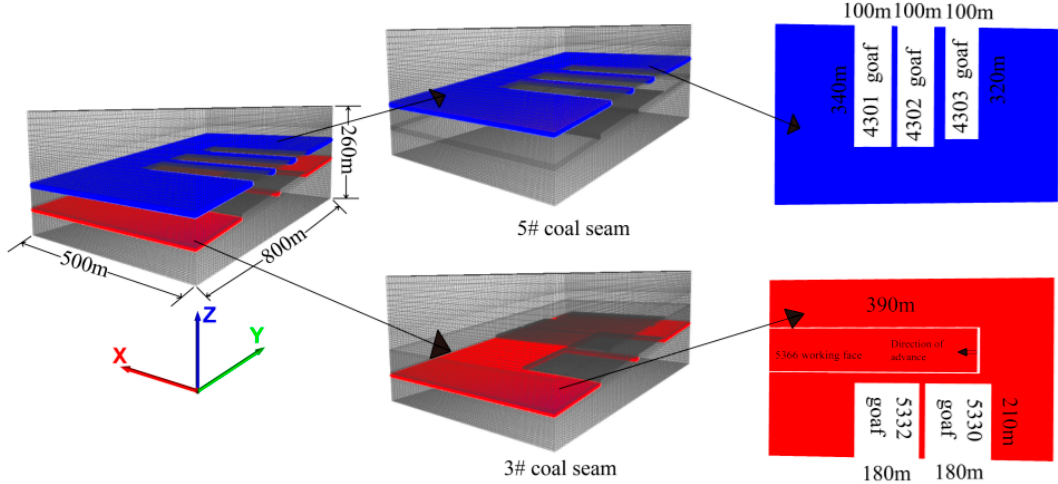
Figure 3. Sketch of the three-dimensional fast Lagrangian analysis of continua (FLAC 3D) mesh for all